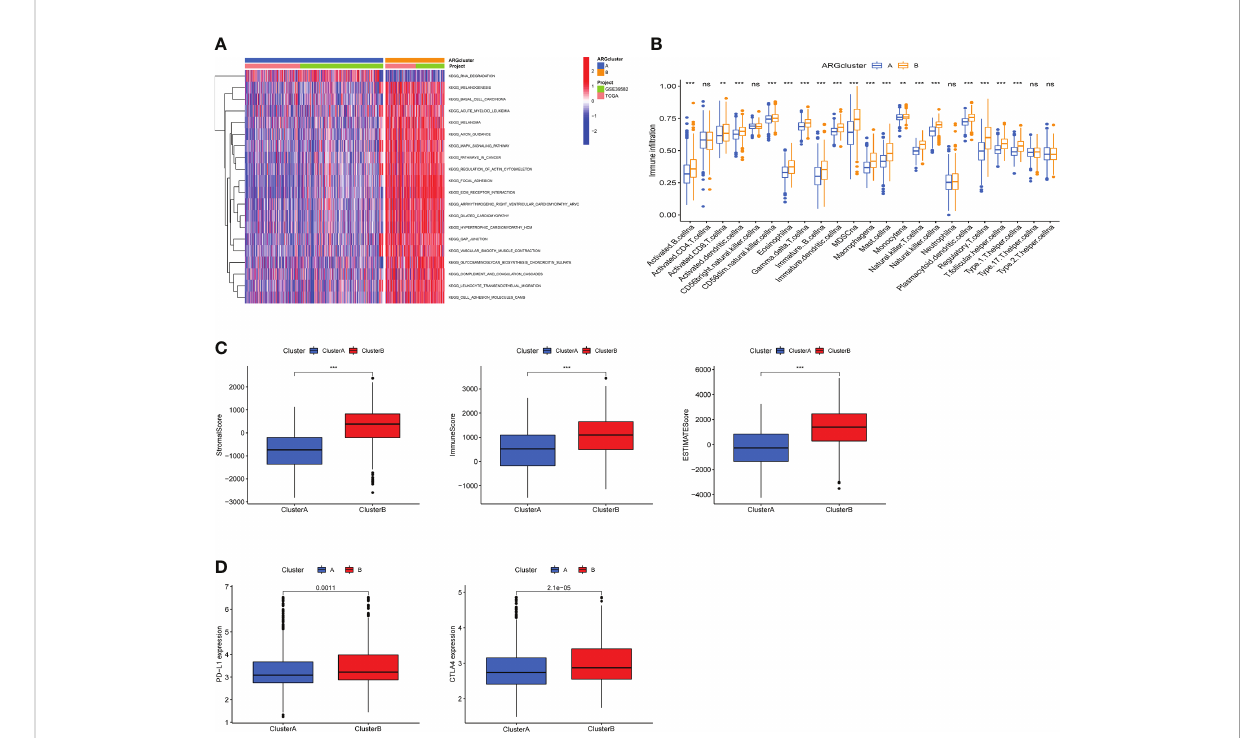
FIGURE 3 Analysis of biological features and tumor immune in fi ltration in two ARGclusters. (A) KEGG-related GSVA analysis showing the biological pathways of two ARGclusters. (B) In fi ltration of 23 types of immune cells in two ARGclusters. (C) Differences of stromal score, immune score and ESTIMATE score between the two ARGclusters. (D) Expression levels of immune checkpoints PD-L1 and CTLA-4 in the two ARGclusters. Adjusted p-values were shown as ns, nosigni fi cant, **P<0.01,